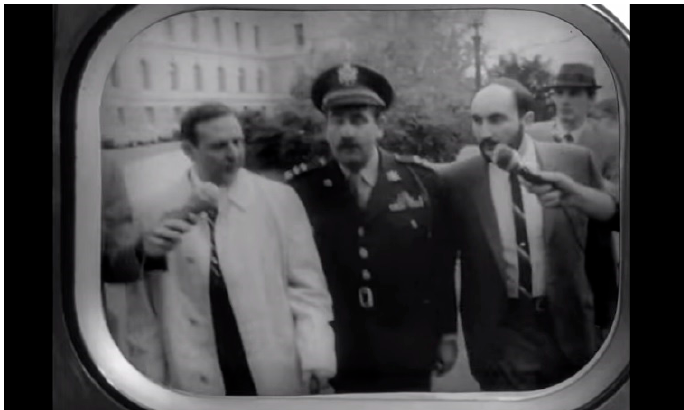
Figure 3. From the final sequence of Night of the Living Dead , the camera focuses on the faces of Ben and the film’s first zombie, emphasizing similitude.